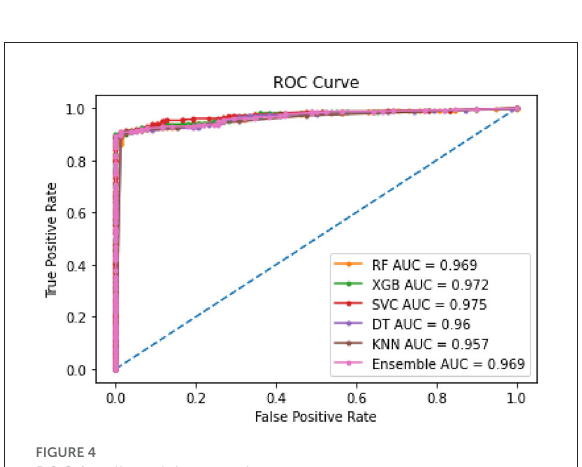
FIGURE4 ROC for all model comparison.